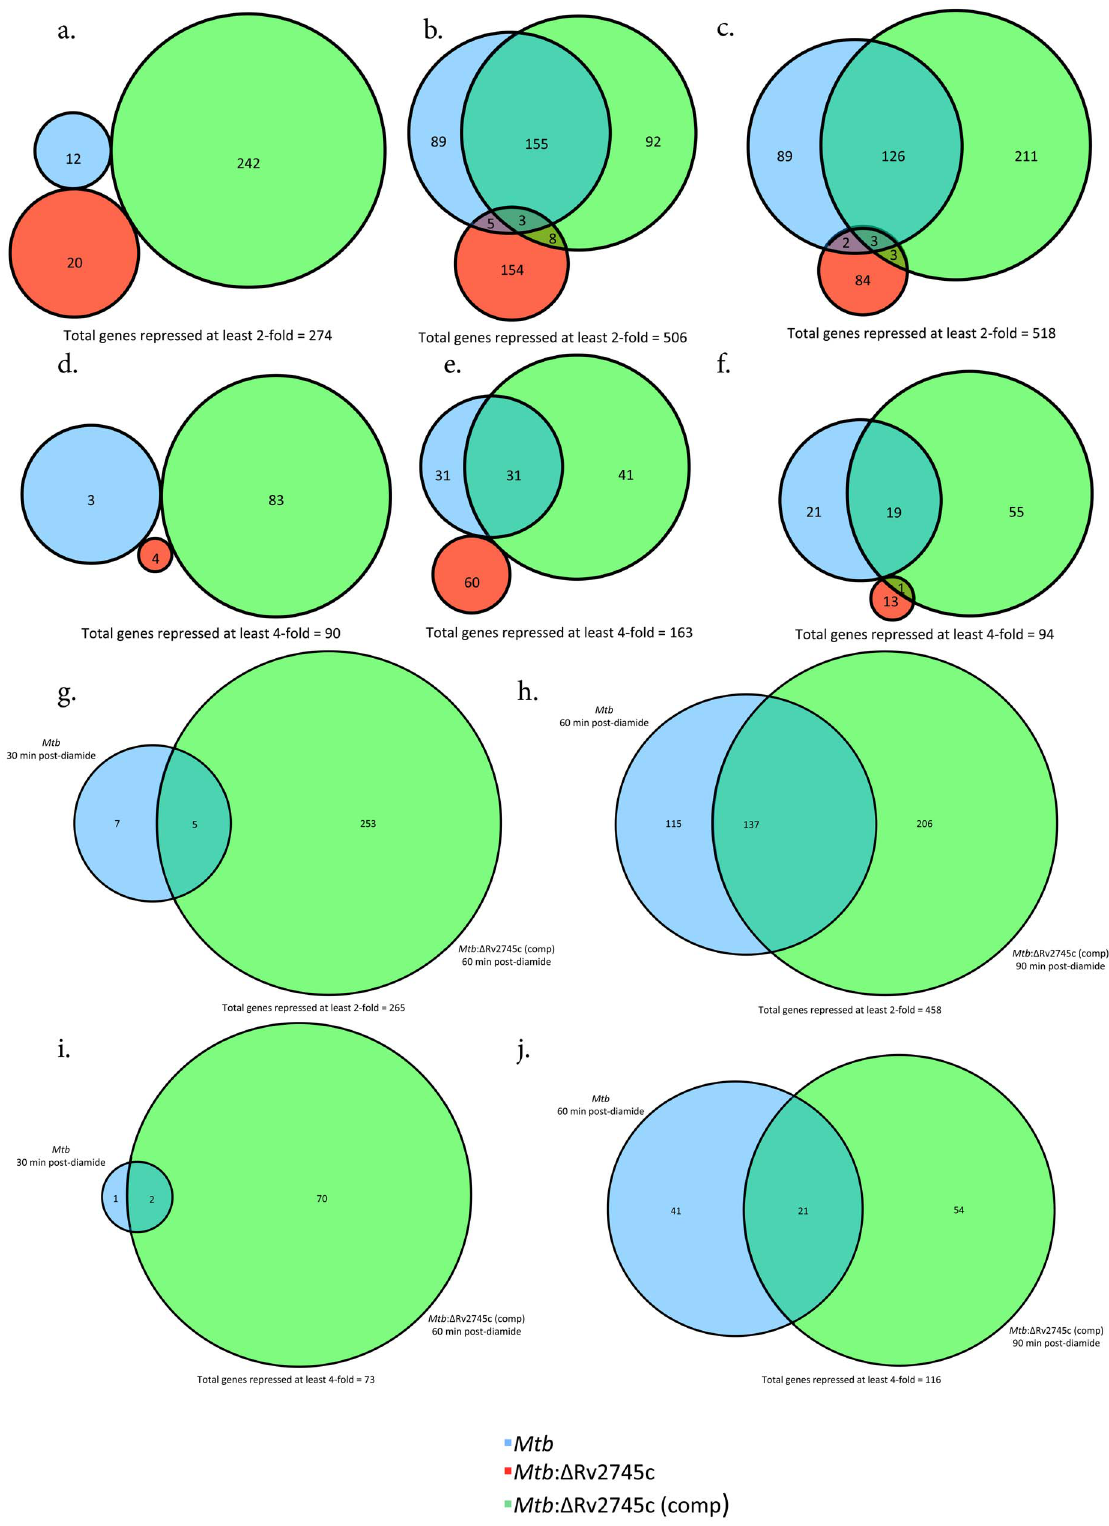
Figure 5. Venn Diagrams of Diamide Repressed Genes. Venn diagrams describe the extent of overlap between gene-expression upon diamide treatment in Mtb (blue circles), Mtb : D Rv2745c (red circles) and Mtb : D Rv2745c (comp) (green circles). Genes repressed at least two-fold at: a.) 30, b.) 60, and c.) 90 min post-diamide treatment are shown. Genes repressed at least four-fold at: d.) 30, e.) 60, and f.) 90 min post-diamide treatment. g–j.): Delayed response of Mtb : D Rv2745c (comp). g.) Genes repressed at least two-fold comparing Mtb at 30 min to Mtb : D Rv2745c (comp) at 60 min and h.) Genes repressed at least two-fold comparing Mtb at 60 min to Mtb : D Rv2745c (comp) at 90 min. i.) Genes repressed at least four-fold comparing Mtb at 30 min to Mtb : D Rv2745c (comp) at 60 min. j.) Genes repressed at least four-fold comparing Mtb at 60 min to Mtb : D Rv2745c (comp) at 90 min. n=3. doi:10.1371/journal.pone.0093604.g005 PLOS ONE |